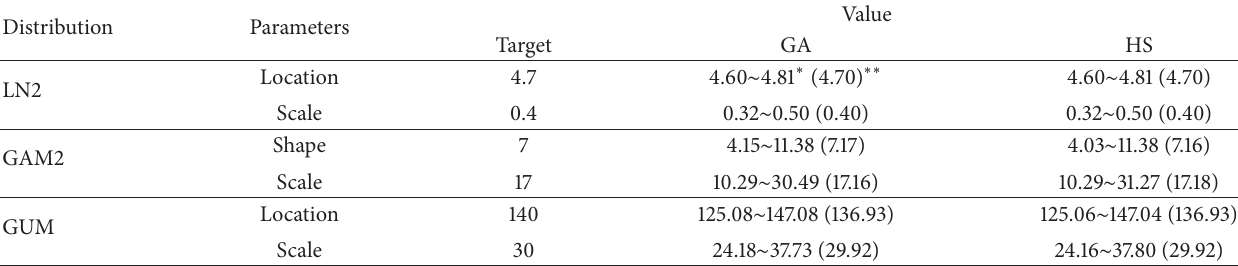
Table 2: Target values for the parameters of employed PDMs and estimated parameters by the GA and HS.